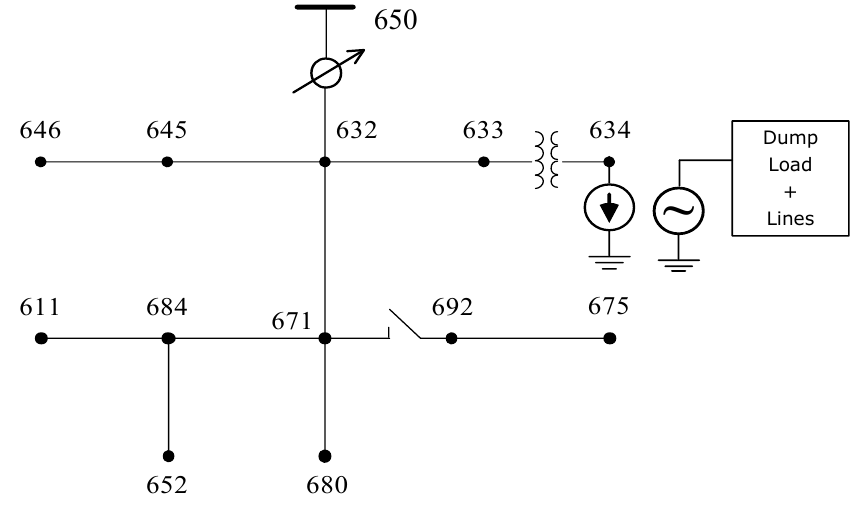
Figure 9. IEEE 13 node test feeder with PHiL test